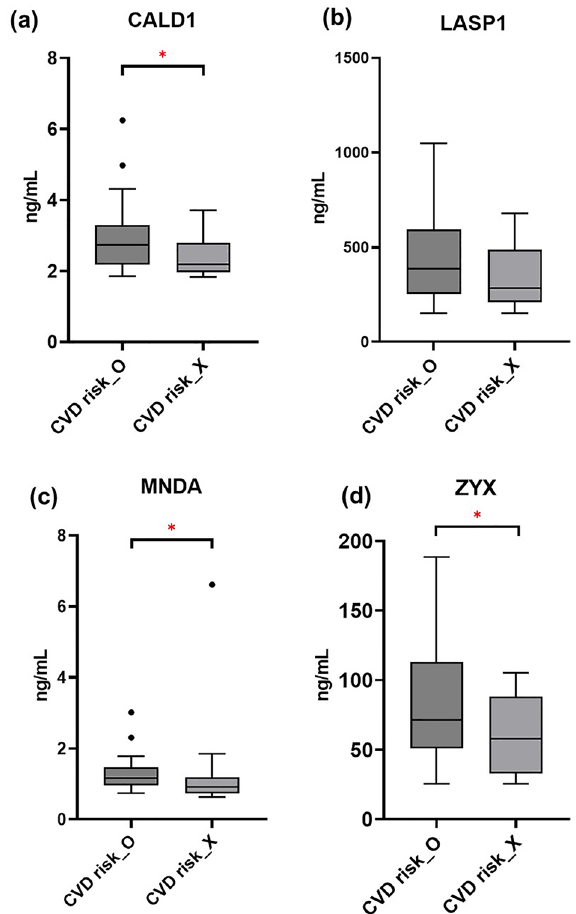
Figure 4. Boxplots of biomarker candidates verified by ELISA. The order of groups is identical in all charts as indicated on the bottom (CVD risk_O: psoriasis groups with CVD risk factors, CVD risk_X: psoriasis groups without CVD risk factors). The groups that show significant differences of the respective protein are indicated by brackets. Statistical significance was defined as *P < 0.05. ( a ) CALD1: Caldesmon, ( b ) LASP1: LIM and SH3 domain protein, ( c ) MNDA: Myeloid cell nuclear differentiation antigen, ( d ) ZYX: